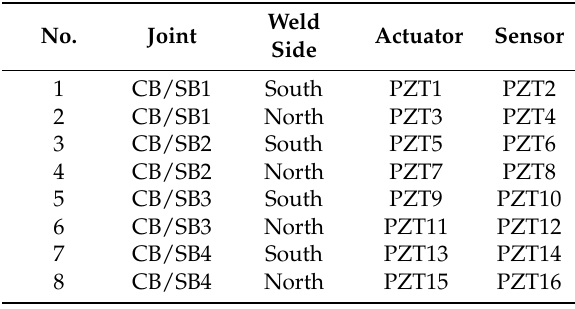
Table 2. The details of PZT transducers in the test specimen.